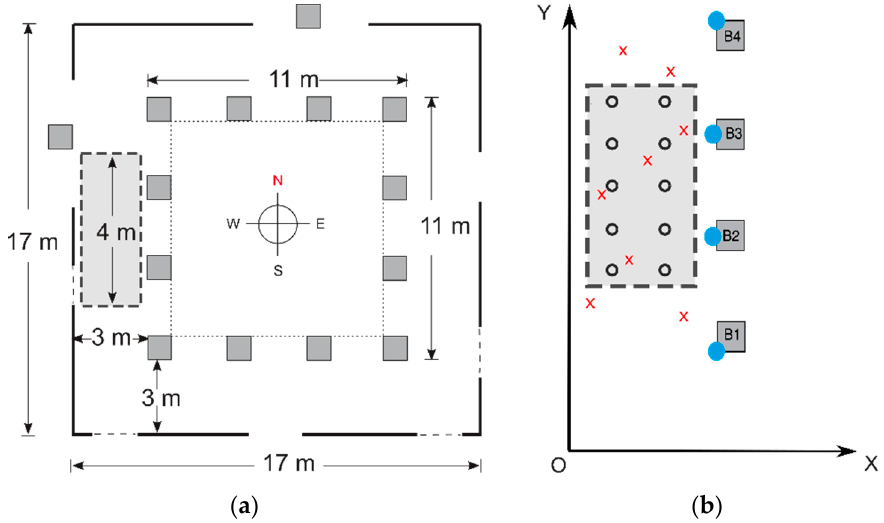
Figure 3. Schematic view of the scenario and testbed: ( a ) Dimensions of scenario and small rectangular testbed along with cardinal directions; ( b ) Representation of the axes of the chosen coordinates, along with beacons (blue dots), reference and test points (black circles and red crosses